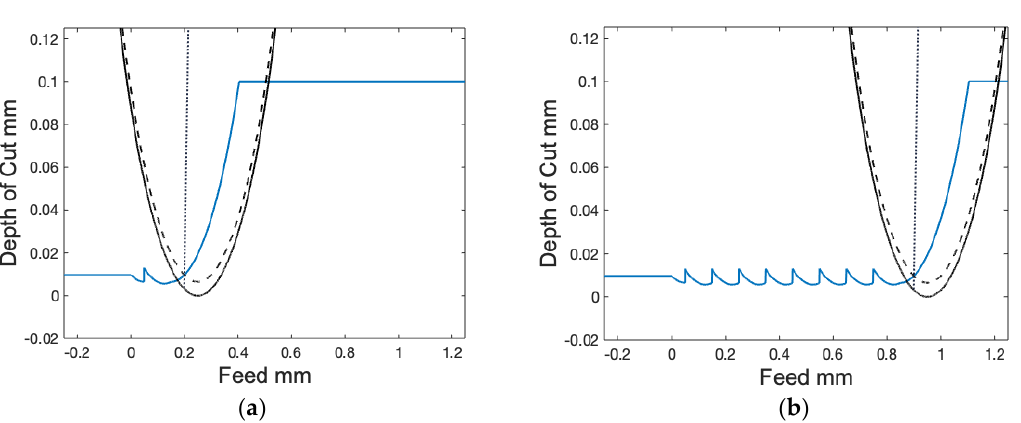
Figure 7. ( a ) Tool geometry in the new path position imposed on the surface profile generated by the previous path; ( b ) surface profile created by the iterative model, shown at equilibrium.